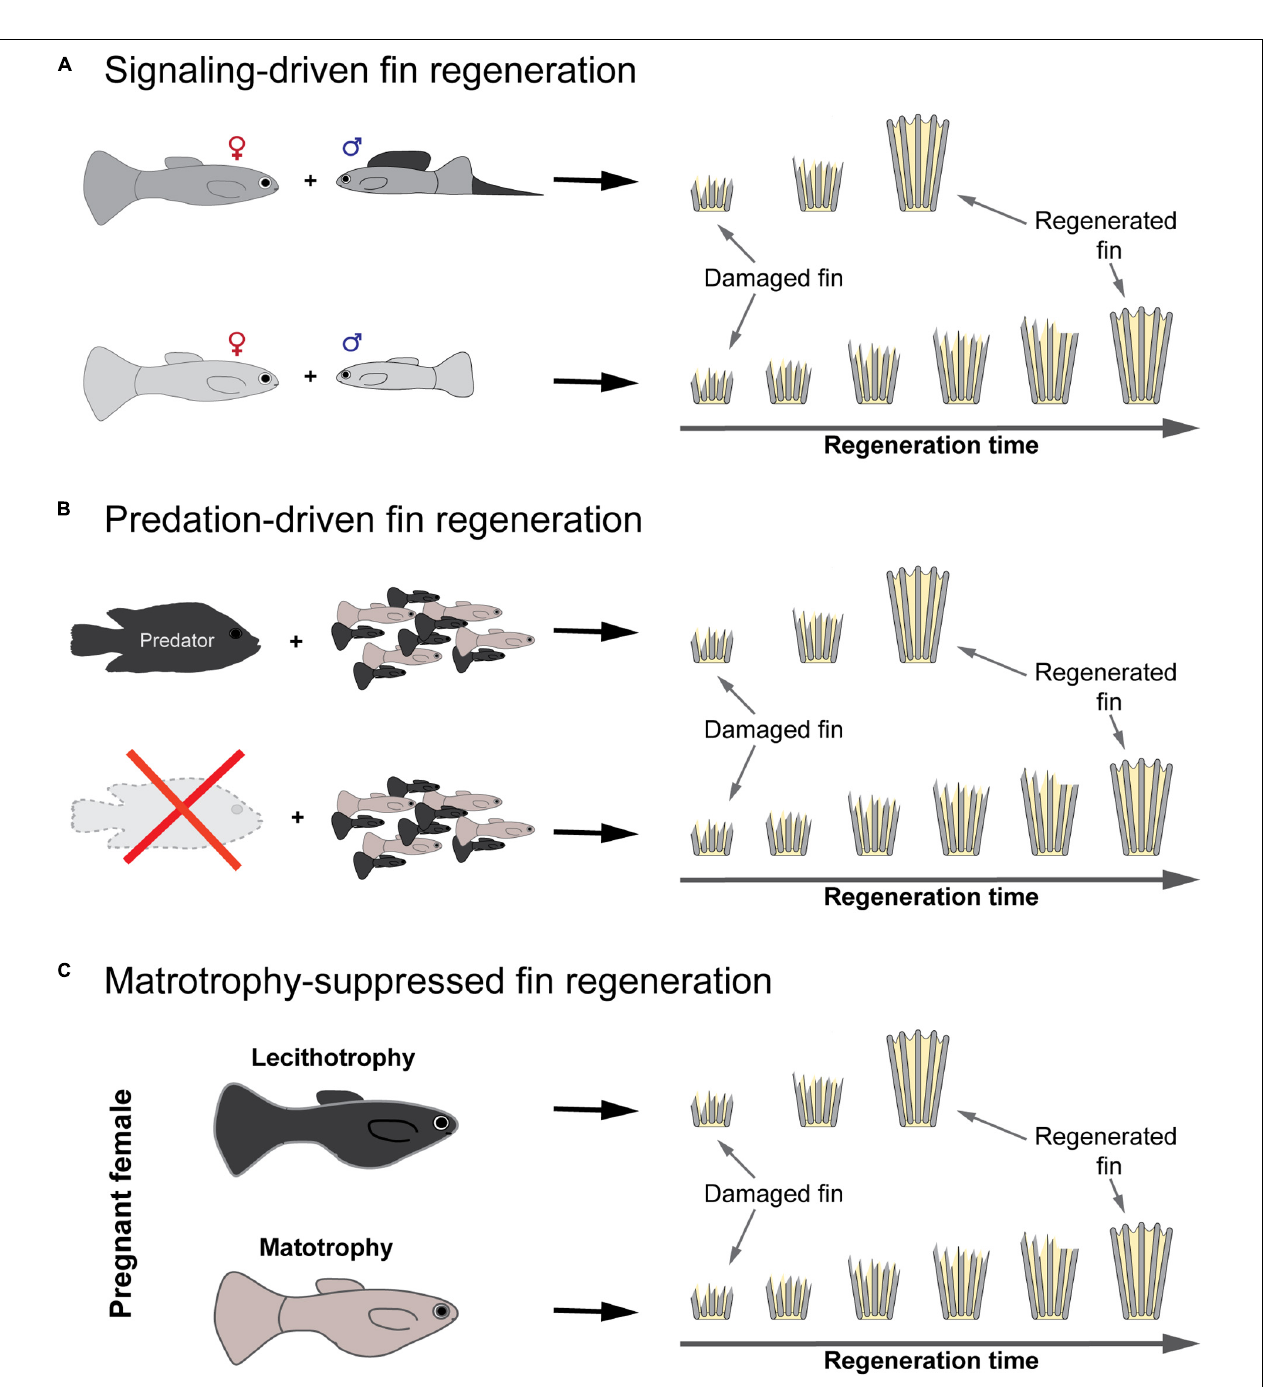
FIGURE 4 | Hypotheses for the evolution of fin regeneration in the fish family Poeciliidae. (A) If fins play an important role in precopulatory sexual selection, then they should be selected to have a faster and more accurate regeneration in males that rely in courtship. (B) If fins play an important role in predator evasion, then they should be selected to have a faster and more complete regeneration when living in a high predation environment. (C) If reproduction and regeneration enter an energetic conflict during pregnancy and a matrotrophic mode of reproduction is energetically more demanding than lecithotrophy, then matrotrophy should be associated with a suppressed female capacity for fin regeneration during